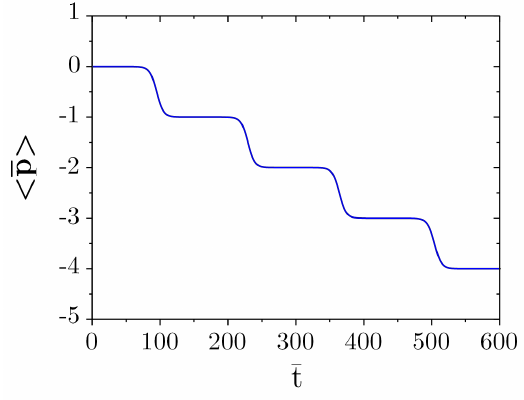
Figure 9. (cid:104) ¯ p (cid:105) vs. ¯ t for ¯ κ = 10, ρ = 1 and ¯ δ = 0.5.